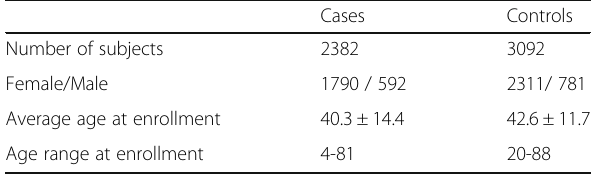
Table 1 Demographic information for the